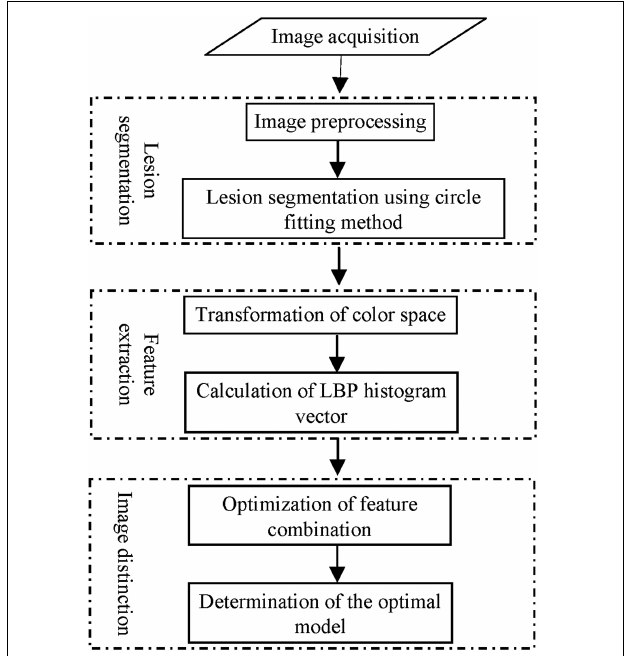
FIGURE 1 | Flow chart of image-based distinction of ring rot and anthracnose on apple